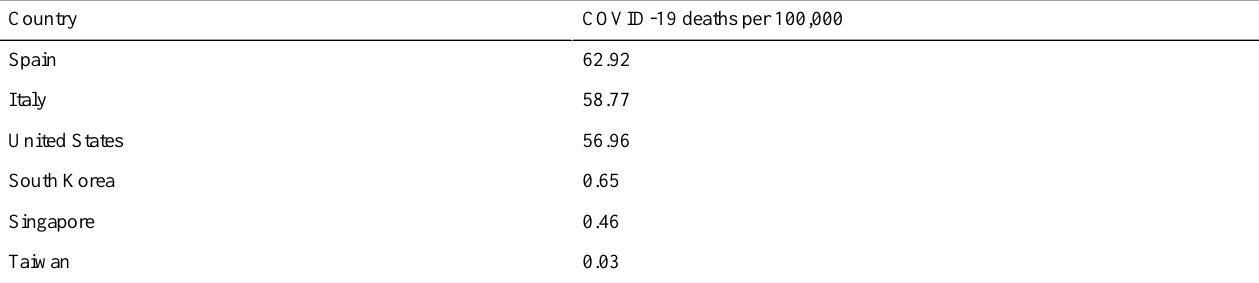
Table 1. Total COVID-19 deaths per 100,000 people by country as of September 6, 2020.